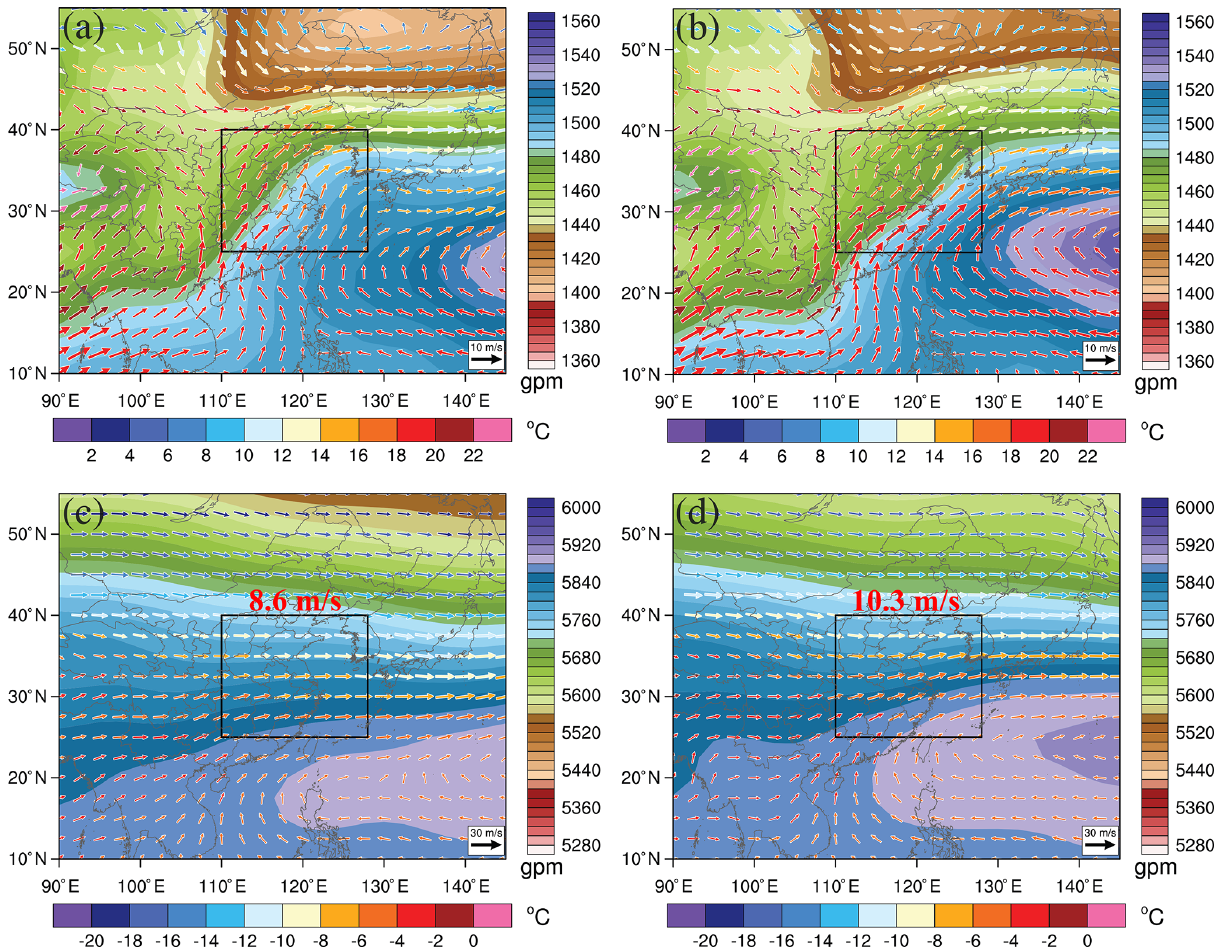
Figure 4. The geopotential height (shaded) and 850hPa wind with temperature (color vector) under (a) SWP1_Pos and (b) SWP1_Neg. The geopotential height (shaded) and 500hPa wind with temperature (color vector) under (c) SWP1_Pos and (d) SWP1_Neg. The red values represent the regionally averaged wind speed at 500hPa in the zone marked by black lines. The boxed area in panels (a) – (d) encloses the